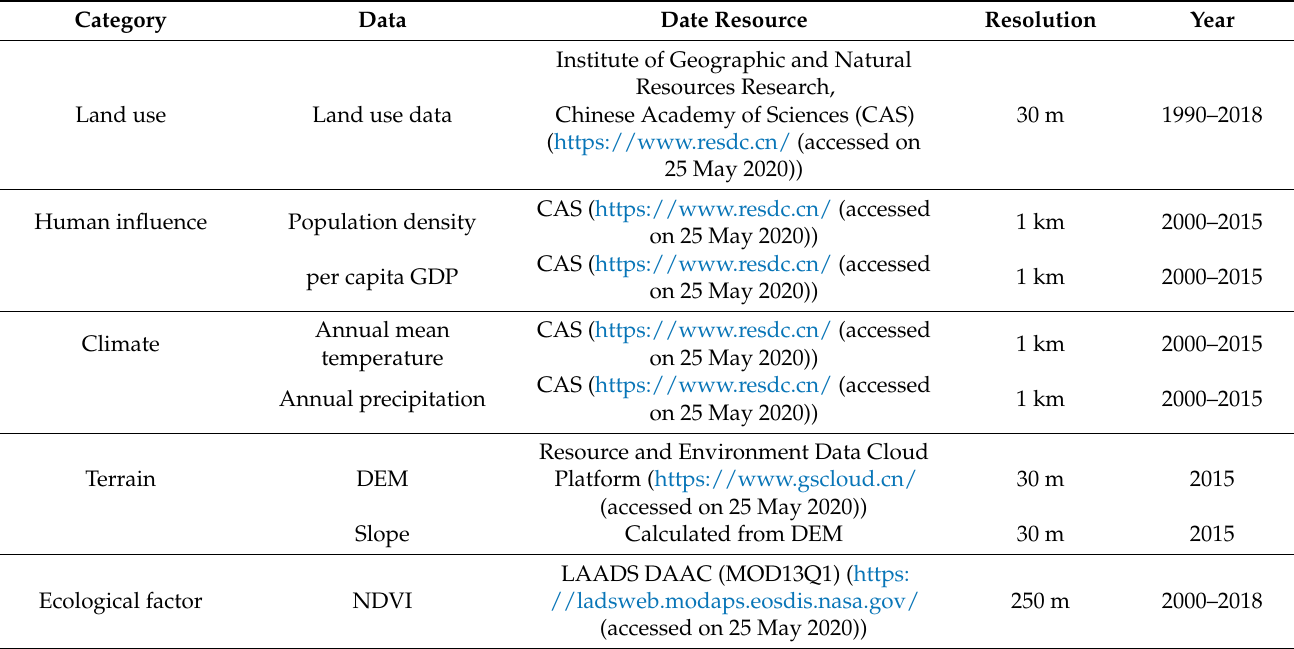
Table 1. List of data used in this study.